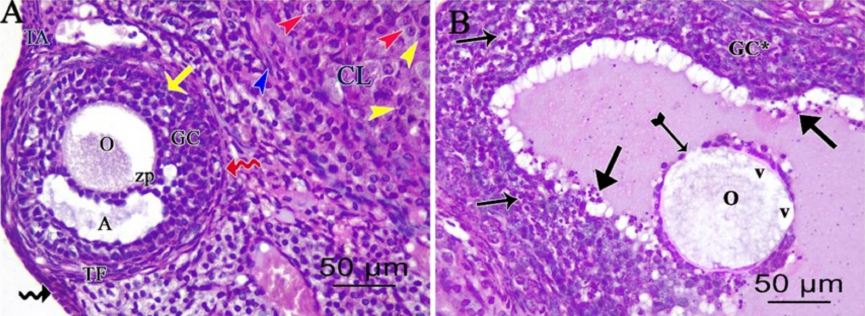
Figure 4. Photomicrographs of (H&E × 400) stained ovarian sections of cisplatin and melatonin- treated group showing: ( A ) Intact surface epithelium (zigzag black arrow) with tunica albuginea (TA) beneath. Corpus luteum (CL) with theca lutein (yellow arrowhead), granulosa lutein cells (red arrowhead), and theca externa cells (blue arrowhead) are seen. The secondary follicle (yellow arrow) is formed of multiple layers of organized granulosa cells (GC) with an antral cavity (A), an oocyte (O), zona pellucida (ZP), basement membrane (red zigzag arrow), and theca folliculi (TF). ( B ) Degenerated Graafian follicle has an oocyte (O) with cytoplasmic vacuolations (V), faint ruptured zona pellucida (tailed arrow), and disorganized granulosa cells (GC*) with pyknotic nuclei (thin long arrows). Some floating granulosa cells (thick arrows) within the antral cavity are still seen.